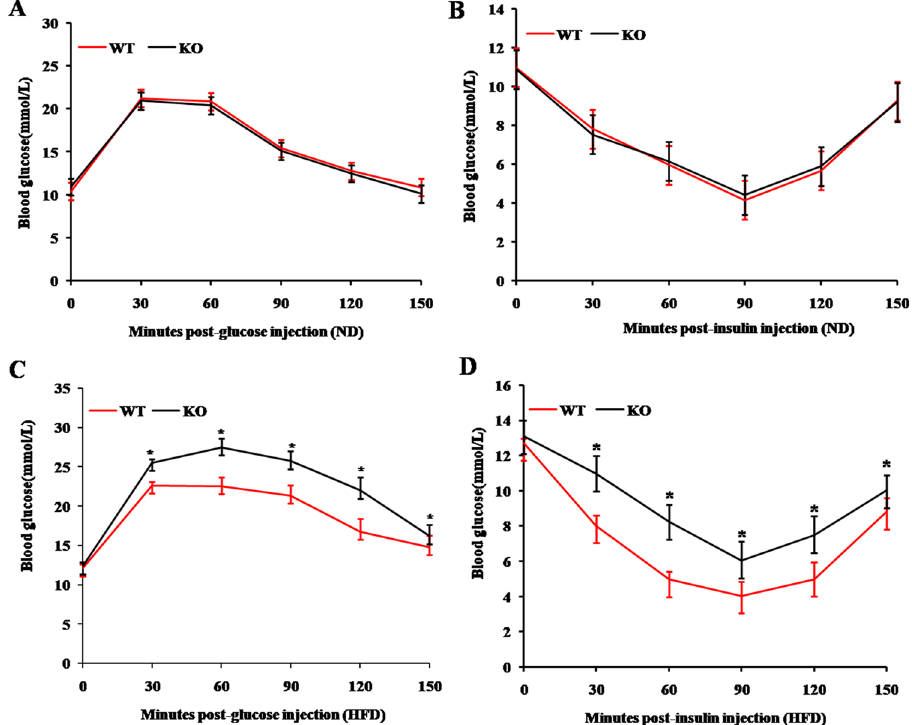
GTT = glucose tolerance test; ITT = insulin tolerance test. Data are presented as mean ± SE (* P < 0.05, n = 8 mice per